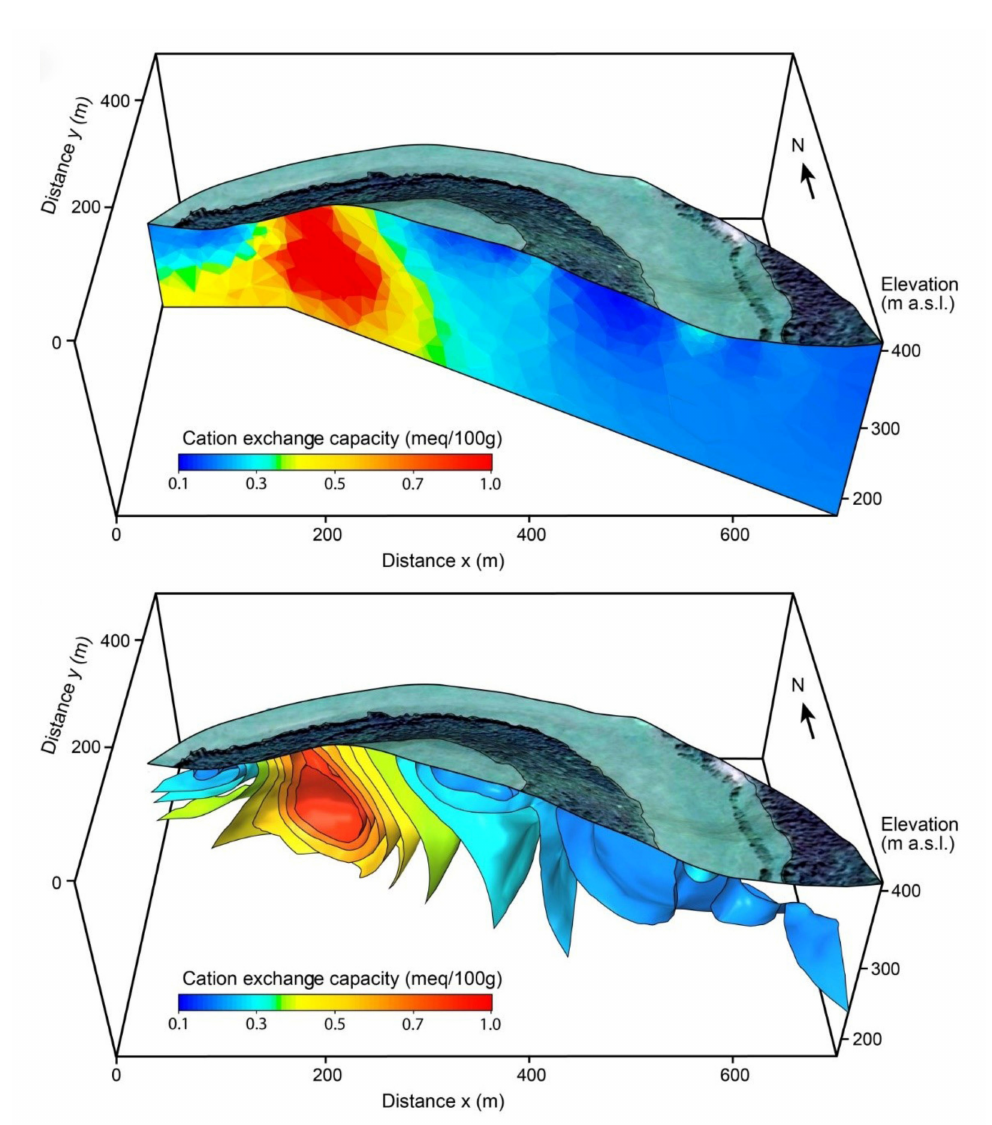
Figure 14. CEC distribution obtained from an induced polarization survey performed at the 1630-dome at Furnas volcano (San Miguel Island,